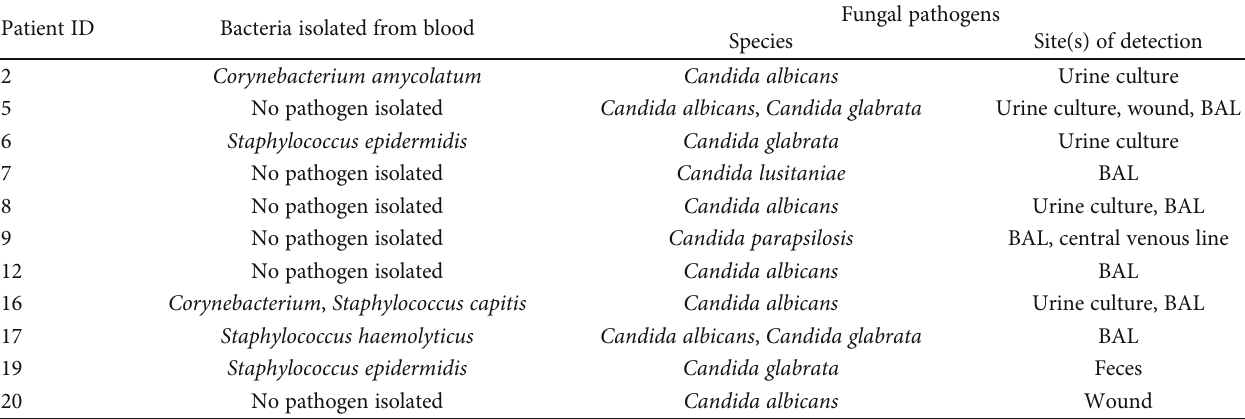
Figure 2: Temporal course of hemodynamic parameters during the early postoperative course in 1-year survivors and 1-year nonsurvivors. CO =cardiac output; PAP syst. =systolic pulmonal arterial pressure; SvO2=mixed venous saturation. Hemodynamic data were obtained from the routinely utilized continuous-cardiac-output (CCO) Swan-Ganz Catheter (Edwards Vigilanz II®). Given are the results of the ANOVA mixed model analysis for repeated measures. Table 3: Pathogens isolated from patients during hospital